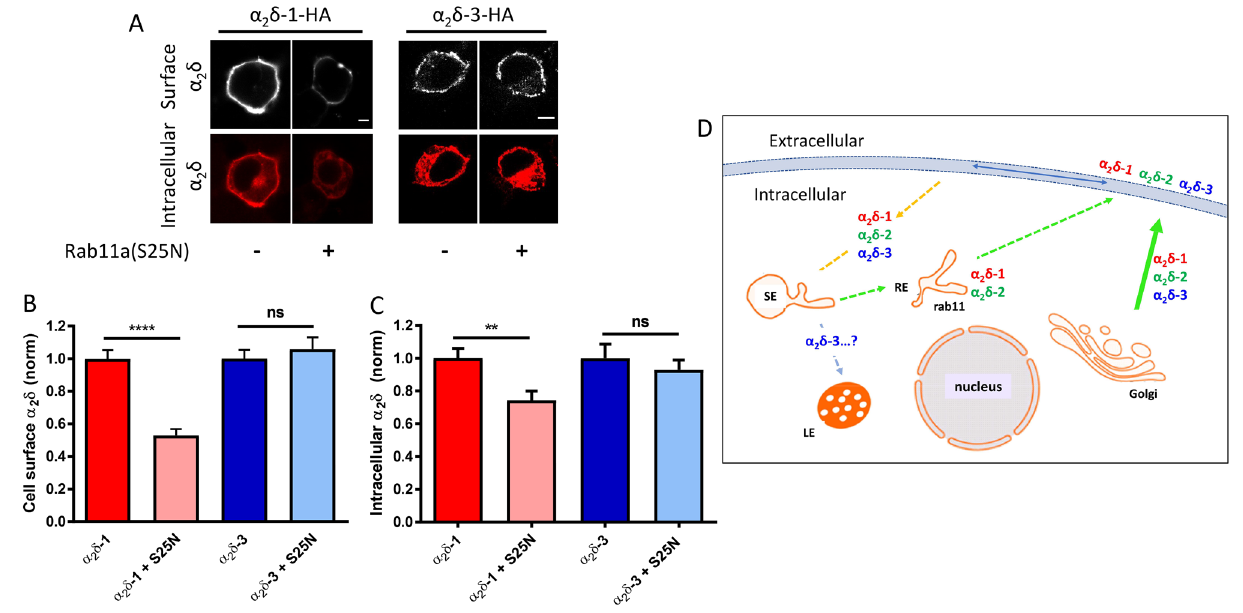
Figure 1. Dominant-negative Rab11a(S25N) reduces steady-state cell-surface expression of HA-tagged α 2 δ-1 but not α 2 δ-3. ( A ) Confocal images of cell-surface (top row) and intracellular (bottom row) HA staining in N2a cells expressing α 2 δ-1-HA (left) or α 2 δ-3-HA (right) in the absence or presence of Rab11a(S25N). Scale bars (5 μm) refer to either α 2 δ-1 or α 2 δ-3 expressing cells. Cell surface HA was detected in non-permeabilised cells and intracellular HA subsequently detected following permeabilization (see Methods). ( B ) Normalized mean cell-surface α 2 δ expression for α 2 δ-1 control (red), α 2 δ-1 + Rab11a(S25N) (pink), α 2 δ-3 control (blue), α 2 δ-3 + Rab11a(S25N) (light blue). ( C ) Normalized mean intracellular α 2 δ expression for α 2 δ-1 control (red), α 2 δ-1 + Rab11a(S25N) (pink), α 2 δ-3 control (blue), α 2 δ-3 + Rab11a(S25N) (light blue). For ( B ) and ( C ), mean fluorescence intensity per cell was normalized to mean α 2 δ control conditions for each experiment. Normalised data were then pooled from 3 separate experiments and plotted as mean ± SEM. Each cell was measured for cell-surface and intracellular HA expression: α 2 δ-1 control (n = 159 cells), α 2 δ-1 + Rab11a(S25N) (n = 161 cells), α 2 δ-3 control (n = 134 cells), α 2 δ-3 + Rab11a(S25N) (n = 135 cells). Statistical significance was determined using Student’s unpaired t test with Welch’s correction; **, P = 0.0022; ****, P < 0.0001. ( D ) Diagram of pathways for α 2 δ membrane expression and recycling, and Rab11 expression. SE = sorting endosome, RE = recycling endosome, LE = late endosome/lysosome. Dotted pathways represent hypothetical